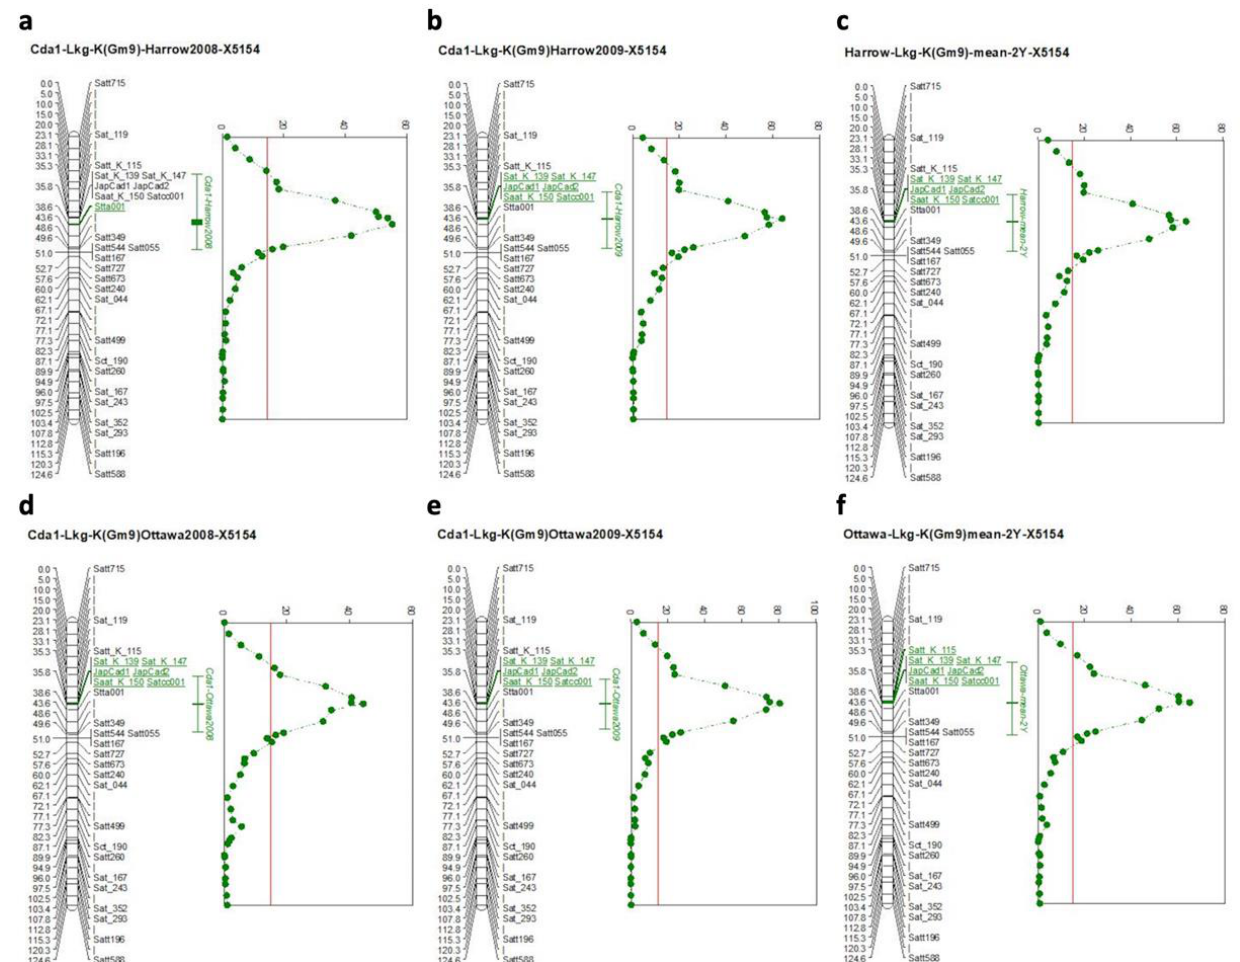
Figure 3 . Cd QTL Lkg-K Cda1 for population X5154 (Chr. 09), ( a ) Harrow 2008 with a threshold of 14.6, ( b ) Harrow 2009 with a threshold of 14.8, ( c ) Harrow mean of two years with a threshold of 14.2, ( d ) Ottawa 2008 with a threshold of 14.8, ( e ) Ottawa 2009 with a threshold of 14.9, ( f ) Ottawa mean of two years with a threshold of 14.9. X is the distance in cM, and Y is the test statistic for SIM main effect (test statistic generated by NQTL).